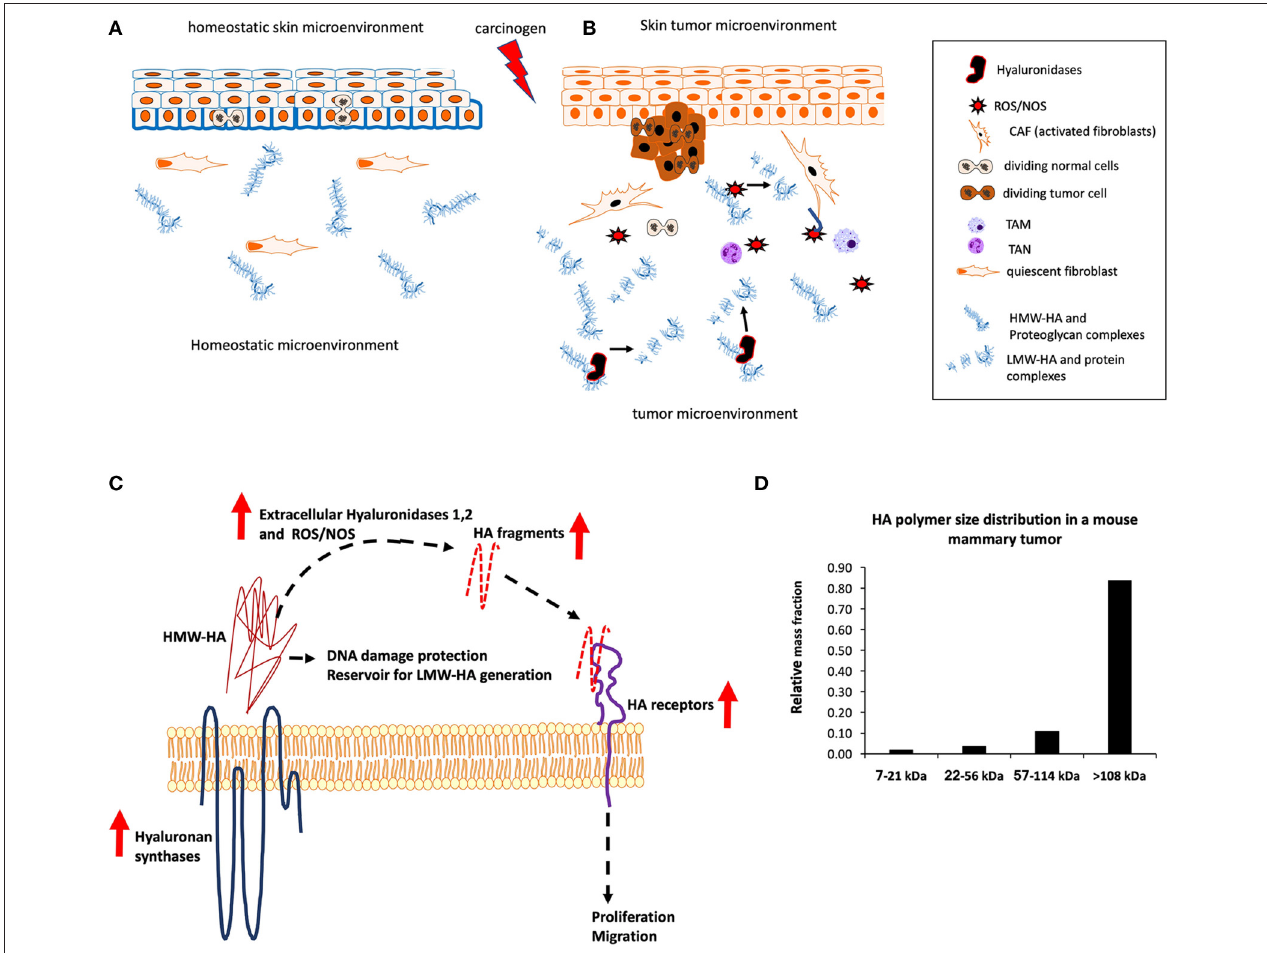
FIGURE 1 | Hyaluronan synthesis and fragmentation in normal and tumor microenvironments. (A) Homeostatic skin is characterized by an organized epidermis with the regulated symmetric and asymmetric division of basal keratinocytes. These are covered by layers of HMW-HA coats (blue outline). Dermal fibroblasts are quiescent and HMW-HA is organized into complexes with proteins and proteoglycans. Extracellular LMW-HA accumulation is restricted. (B) Tumor-initiating events result in disorganized growth of epidermal cells and changes to HA organization and processing. HA synthesis increases, hyaluronidases are expressed/released and reactive oxygen/nitrogen species (ROS/NOS) production is high, resulting in HA fragmentation and reduced organization of macromolecular complexes. HMW-HA coats around epidermal cells are reduced. LMW-HA activates fibroblasts (CAFs, cancer-associated or activated fibroblasts) and attracts immune cells [tumor-associated neutrophils (TANs) and tumor-associated macrophages (TAMs)] that produce ROS/NOS. The fragmented and disorganized tumor microenvironment supports tumor proliferation and evasion of immune surveillance. (C) In disease states such as tumors or chronically inflamed tissues, native or HMW-HA synthesis is increased by constitutively elevated HAS expression. LMW-HA accumulates due to increased expression and activity of extracellular hyaluronidase activity and reactive oxygen/nitrogen species (ROS/NOS) produced by stressed tissues. LMW-HA activates pro-migratory and proliferation pathways through CD44, RHAMM and TLR2,4, whose expression is also increased. In a disease such as cancer, HMW-HA contributes to a stem cell-like microenvironment that is immuno-suppressive and may protect tumor cells from DNA damage. (D) The continued accumulation of HMW HA polymers also provides a source for